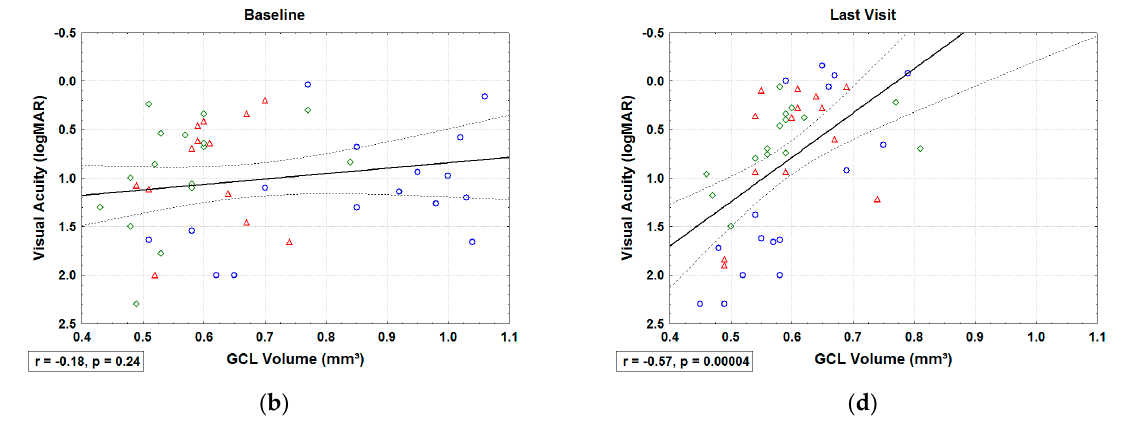
Figure 6. Scatterplots of correlation analyses between visual acuity and OCT measurements in LHON patients before and after idebenone treatment. Significant associations were found only after treatment. ( a ) Visual acuity (VA) vs. peripapillary retinal nerve fiber layer (pRNFL) thickness at baseline: r = − 0.09, p = 0.56. ( b ) VA vs. macular ganglion cell layer (GCL) volume at baseline: r = − 0.18, p = 0.24. ( c ) VA vs. pRNFL thickness at last visit: r = − 0.56, p = 0.00005. ( d ) VA vs. macular GCL volume at last visit: r = − 0.57, p = 0.00004. Blue circles: acute patients, red triangles: early chronic patients, green diamonds: late chronic patients; logMAR scales were reversed.